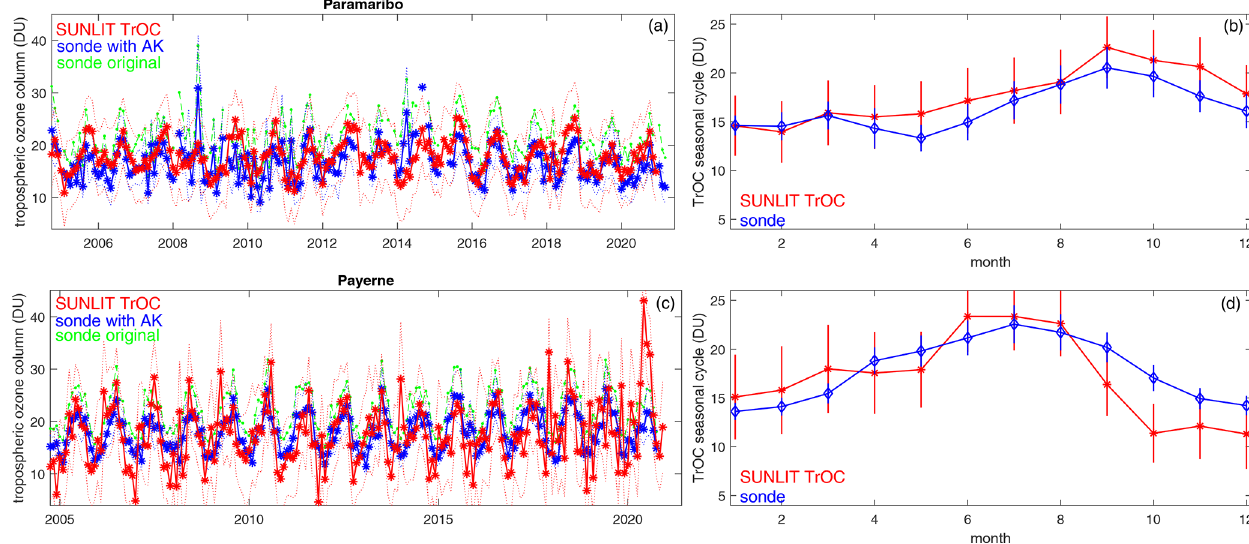
Figure 15. (a, c) Monthly mean tropospheric ozone column from ground to 3km below tropopause altitude from OMI-LIMB (red line), integrated ozonesonde profiles (dashed green line), and integrated ozonesonde with approximate OMI averaging kernel applied (blue line, see text for details). Uncertainties for OMI-LIMB and ozonesonde TrOC with averaging kernel are indicated by dotted lines in panels (a) and (c) . (b, d) Seasonal cycle with 2 σ uncertainties for SUNLIT TrOC (OMI-LIMB) and ozonesonde